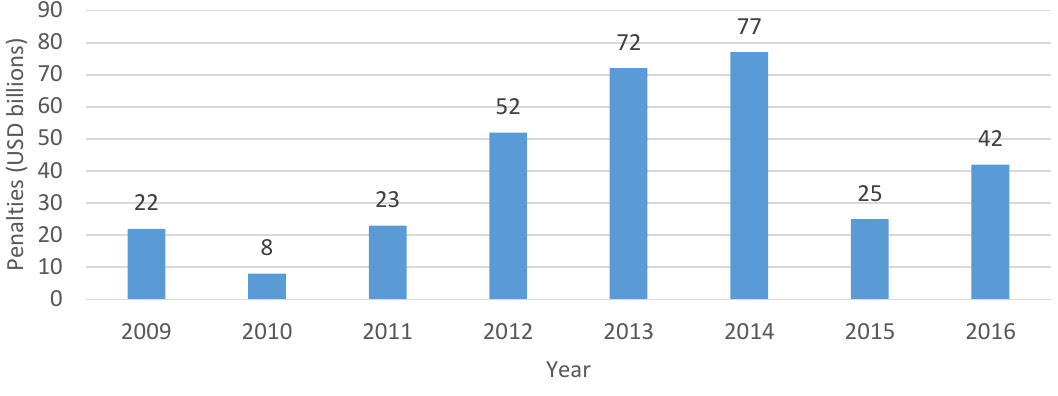
Figure 1. Dynamics of penalties payments by banks during 2009–2016 financial